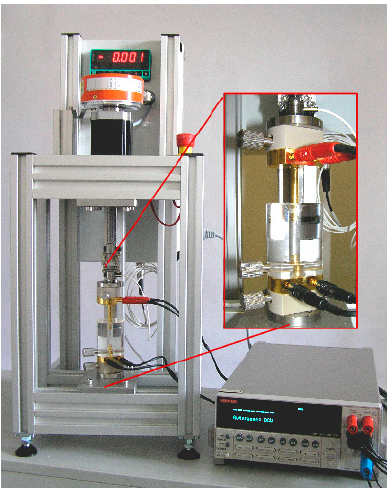
Figure 1. Equipment used for electrical powder conductivity measurements (photo by Dr. Wolfgang Jenschke, Leibniz Institute of Polymer Research Dresden, Dresden, Germany).